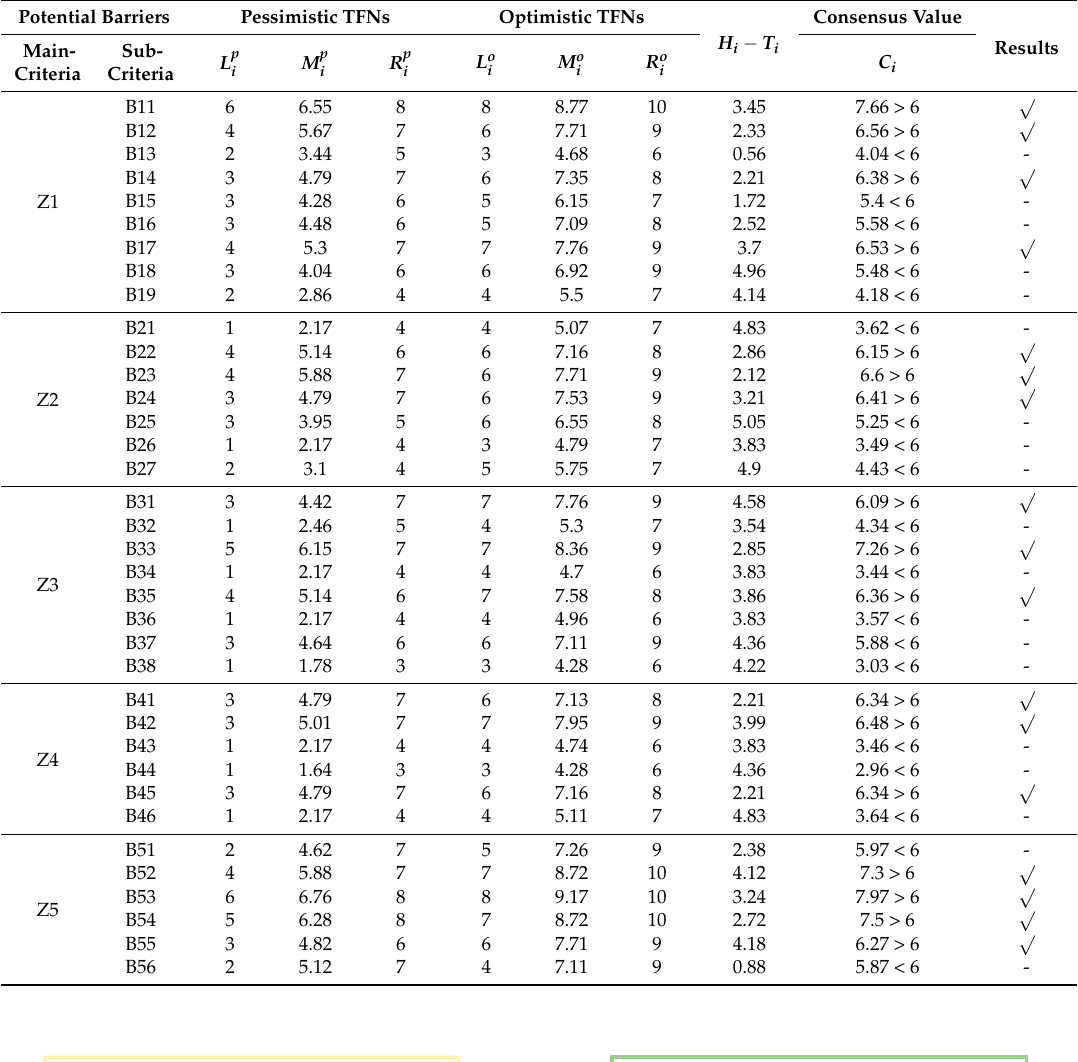
Table 6. Calculation results of financing barriers based on the fuzzy Delphi method. Potential Barriers Pessimistic TFNs Optimistic TFNs